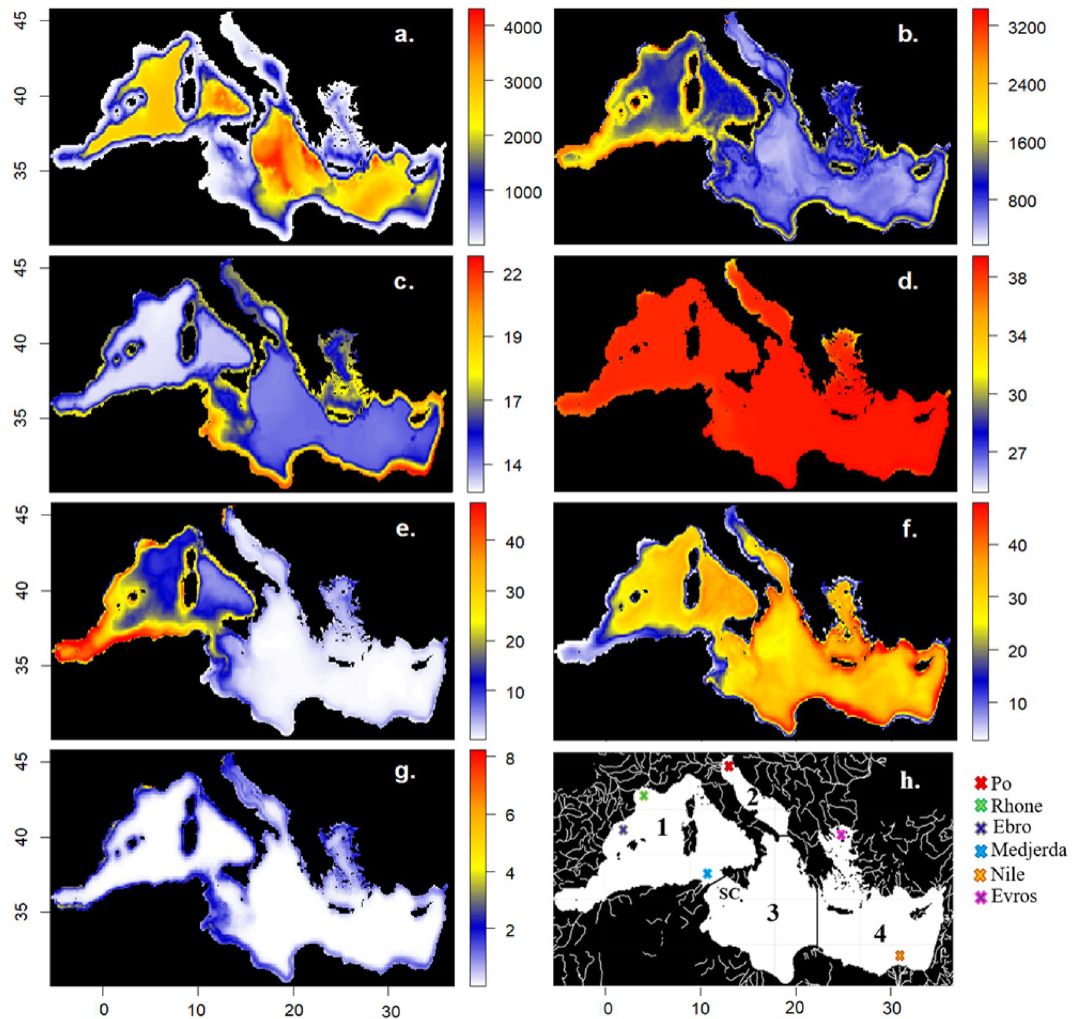
Figure 4. The hydrodynamic-biogeochemical model outputs: ( a ) bathymetry (m); ( b ) primary production (PP, t/km 2 /year); ( c ) temperature (°C); ( d ) salinity (psu); ( e ) large phytoplankton biomass (t/km 2 ); ( f ) small phytoplankton biomass (t/km 2 ); ( g ) detritus biomass (t/km 2 ) used to drive the Mediterranean Sea Ecospace module. Maps 2b–2g are presented as mean for the period 1995–2016 and for the entire water column. Map 4h shows the river loads (white lines and colored crosses) included in GETM-MedERGOM, the Sicilian Channel (SC), and the four main divisions of the Mediterranean Sea accordingly to the European MSFD (Western Mediterranean Sea (1); Adriatic Sea (2); Ionian and Central Mediterranean Sea (3); Aegean and Levantine Sea (4)) to facilitate the visualization of main rivers and areas mentioned in